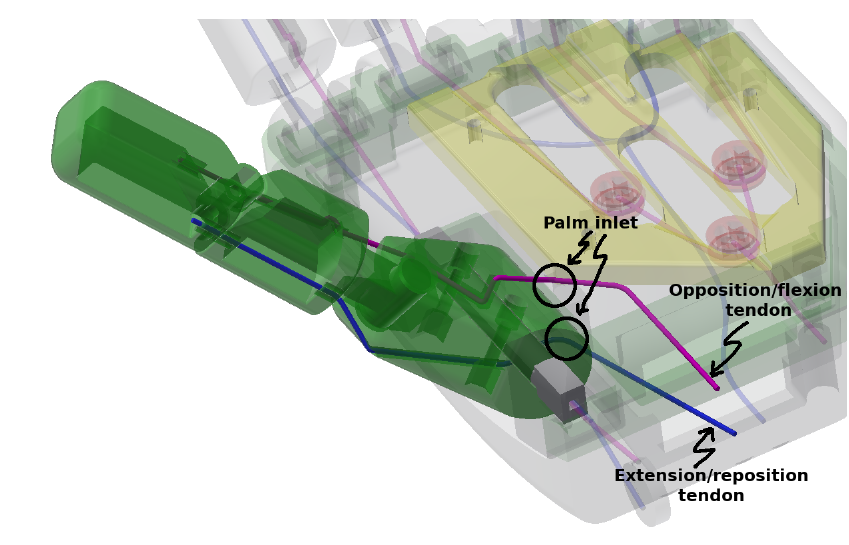
Figure 7. Diagram of the internal tendons for opposition/flexion and extension/reposition move- ments of the